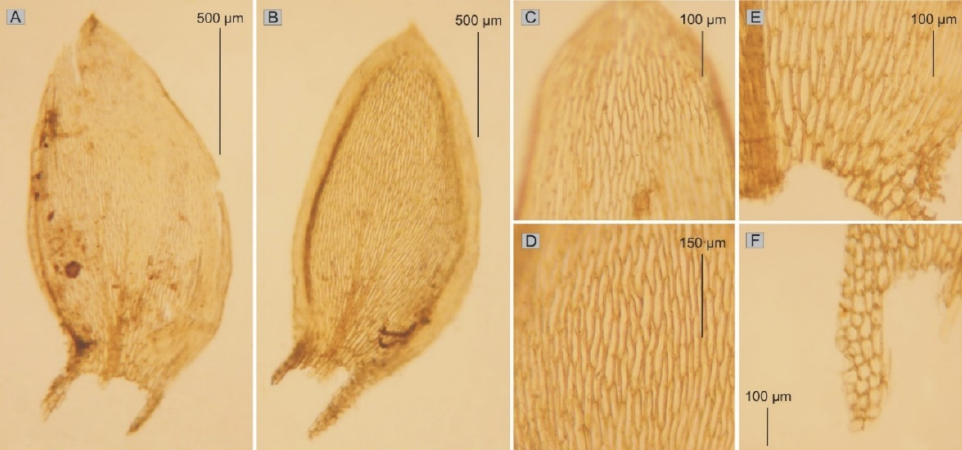
Figure 5. The most important taxonomic features of the epitype of H . denticulatum var . obtusifolium : ( A , B ) leaves; ( C ) cells from the top; ( D ) from the middle part; ( E ) from the lower part of the leaf; ( F ) decurrent cells (from the H . denticulatum var . obtusifolium BM000890810, photo by G.J. Wolski, Ł ód ź , April 2022).